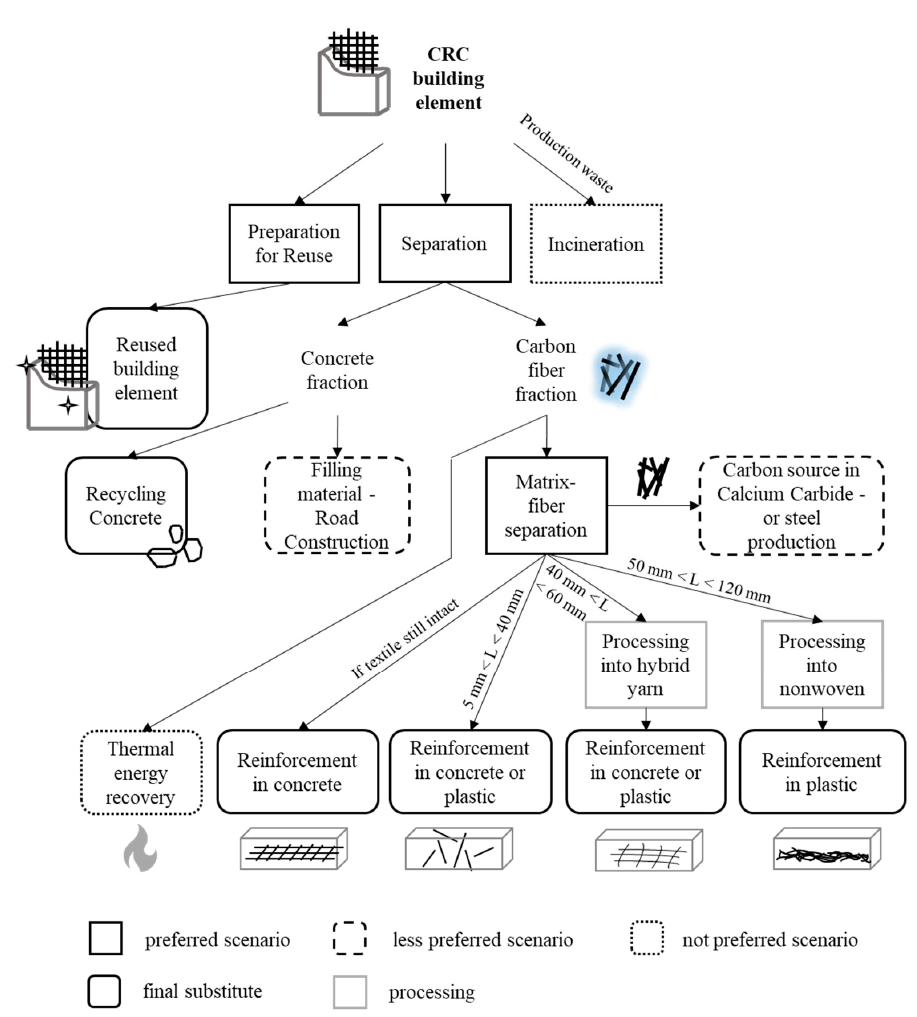
Figure 1. EoL of the CRC building part (own illustration)